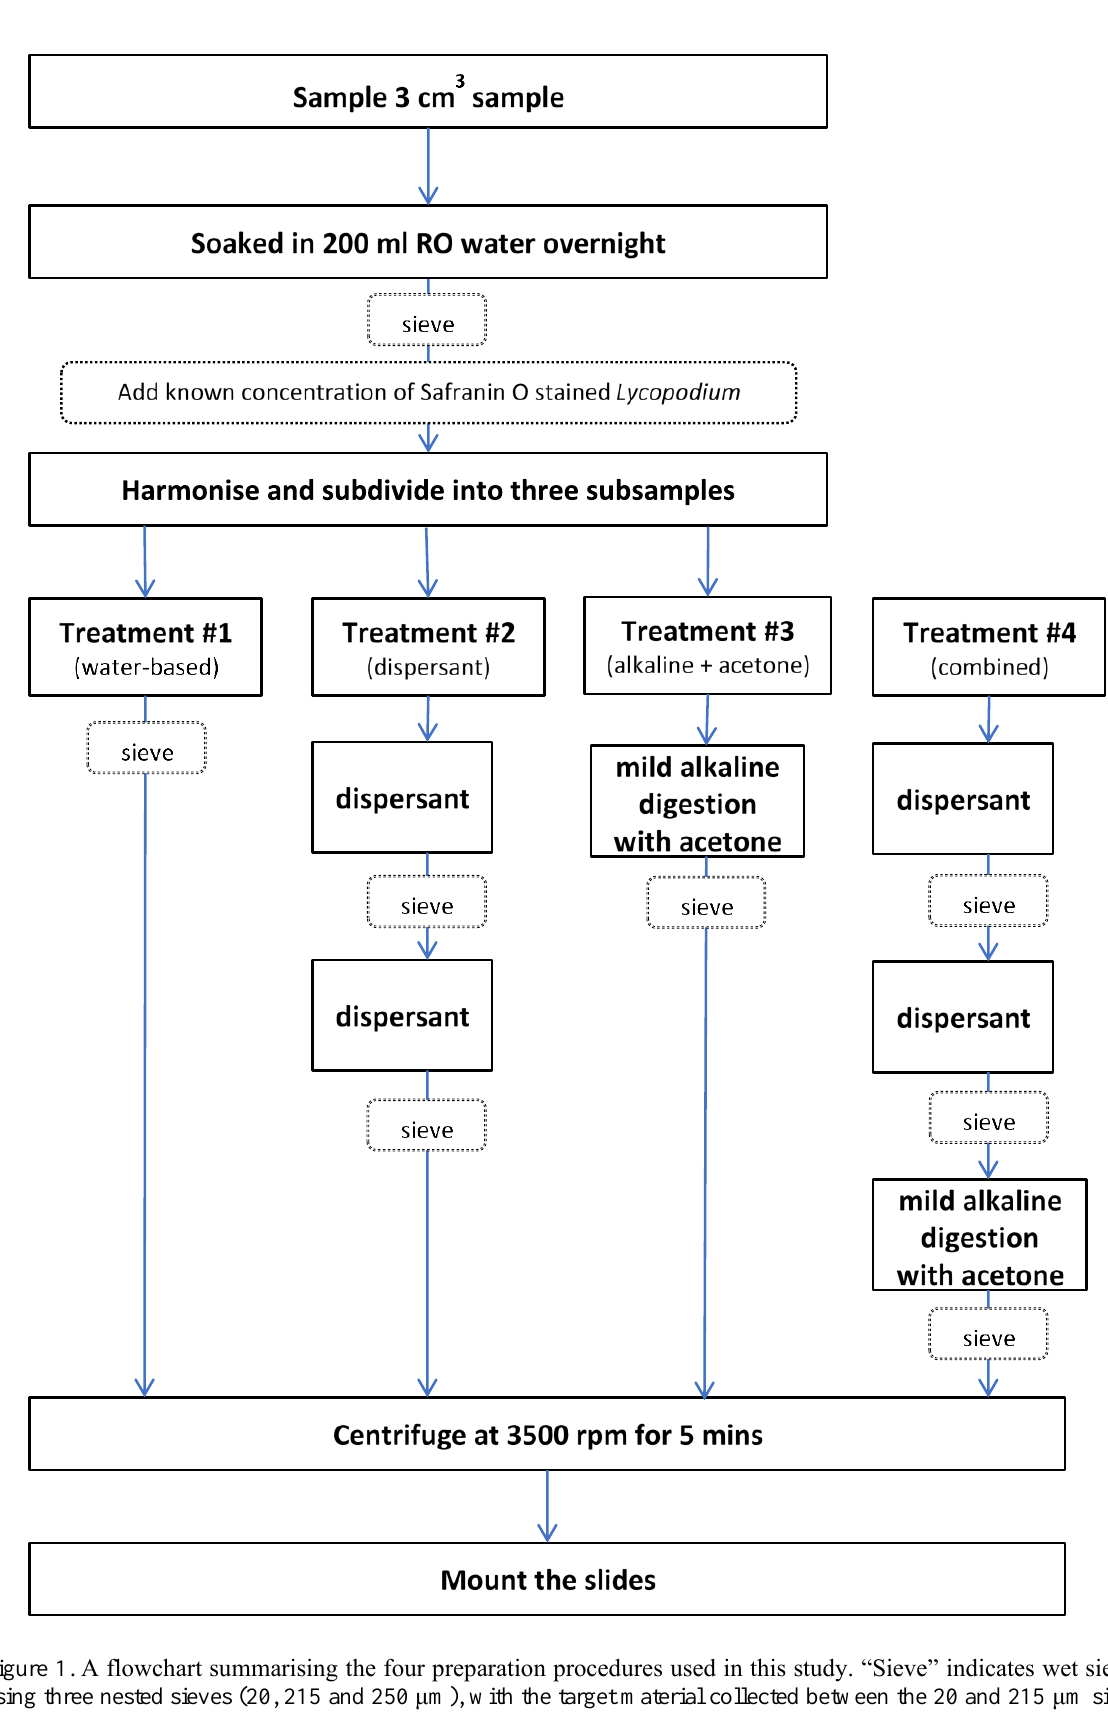
Figure 1. A flowchart summarising the four preparation procedures used in this study. “Sieve” indicates wet sieving using three nested sieves (20, 215 and 250 μm), with the target material collected between the 20 and 215 μm sieves. “Dispersant” indicates adding the subsample to 100 ml of 5 % sodium metapyrophosphate and 4 hours on a shaker table (110 rpm). The “alkaline digestion” was with 20 ml RO water + 25 ml acetone + 5 ml 10 % NaOH + sample, on a 80 °C hotplate for 5